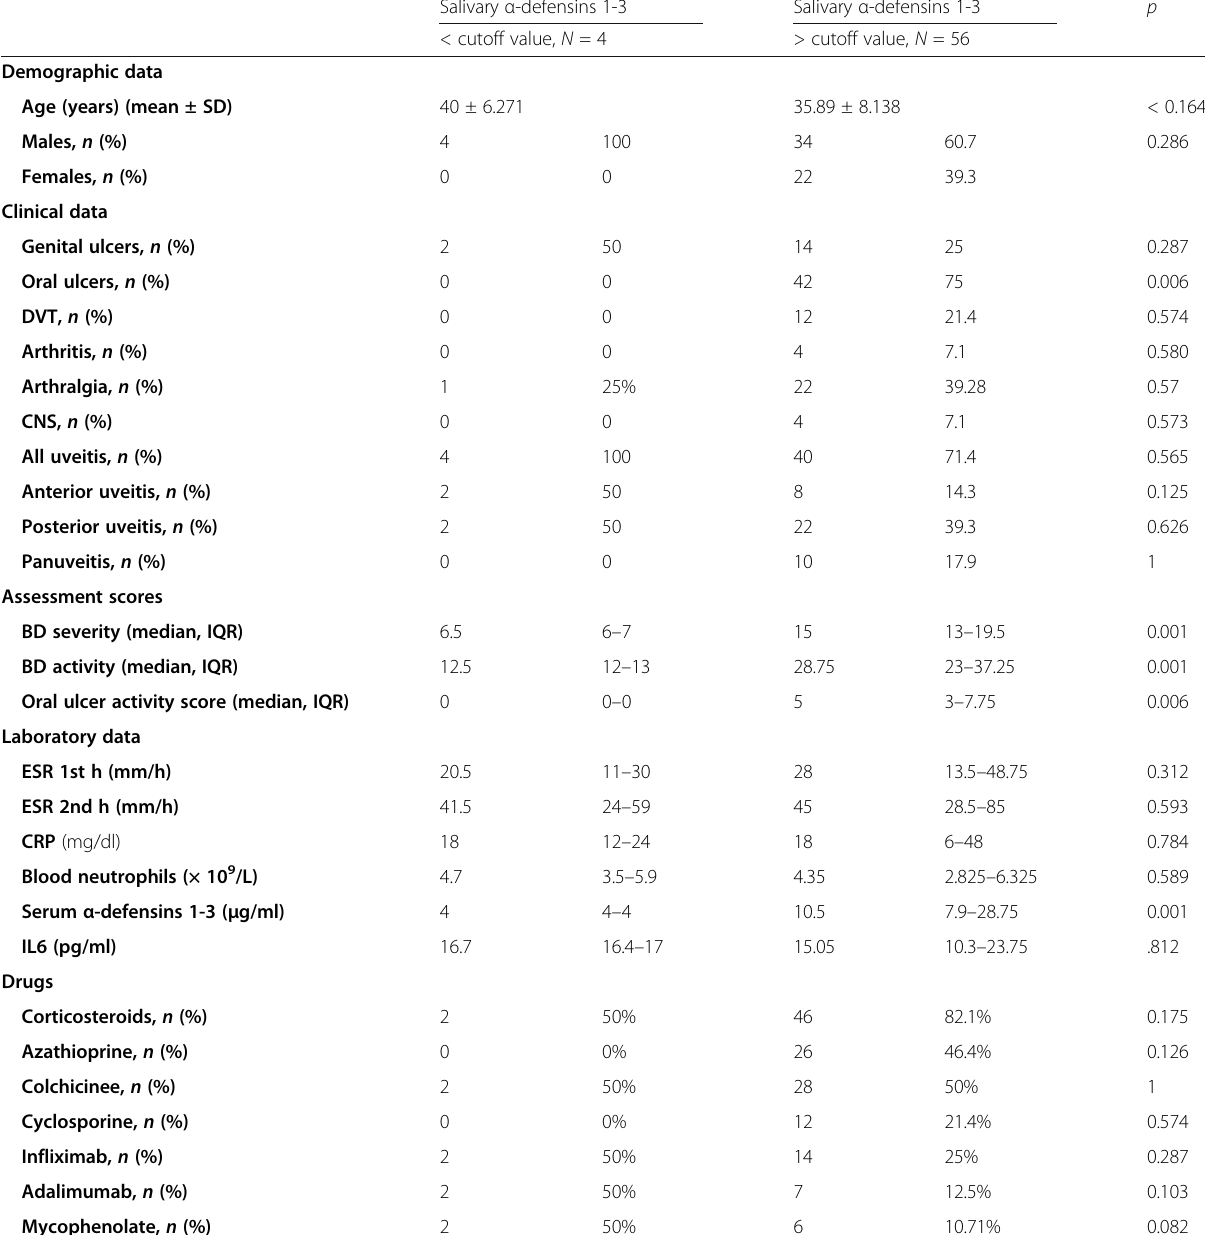
Table 2 Comparison of demographic data, clinical symptoms, clinical scores and laboratory investigations according to salivary α - defensins 1-3 cutoff